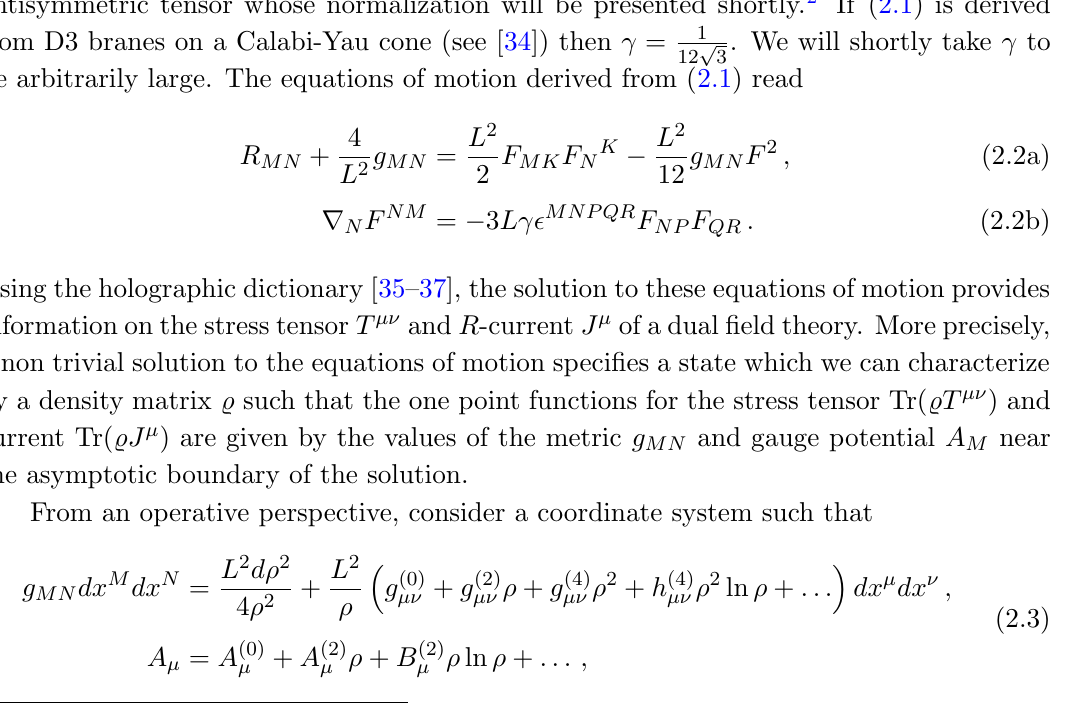
(cid:12) (cid:12) (cid:12) 3 M(cid:13)=(cid:25) 2 T 2 (cid:12) = 2 : 66 with